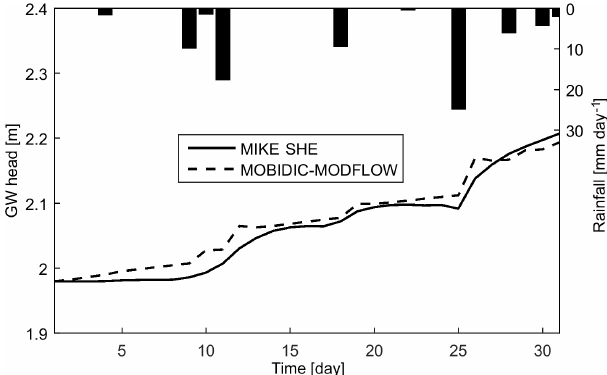
Figure 11. Simulated water table depth by MIKE SHE (solid lines) and MOBIDIC–MODFLOW (dashed lines) at the outlet grid of Borden